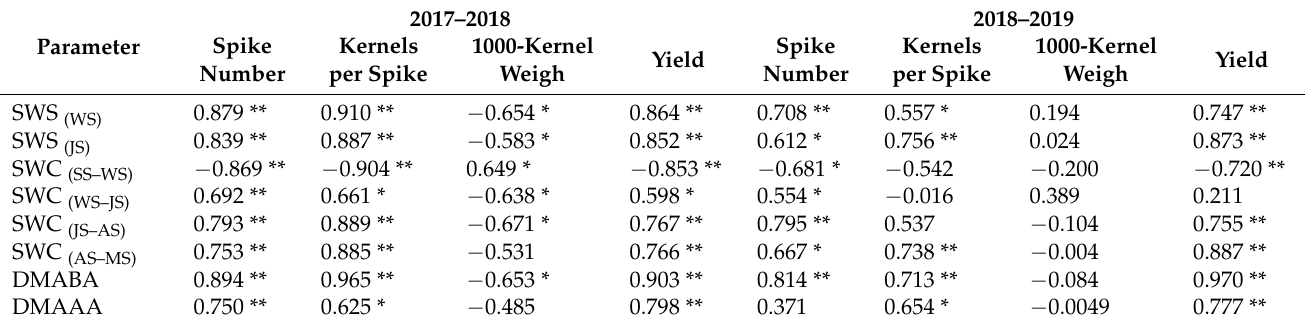
Table 6. Correlation coefficients between grain yield, soil water storage, dry matter accumulation and water consumption from sowing to overwintering (SS-WS, SW), overwintering to jointing (WS-JS, WJ), jointing to anthesis (JS-AS, JA) and anthesis to maturity (AS-MS, AM) of